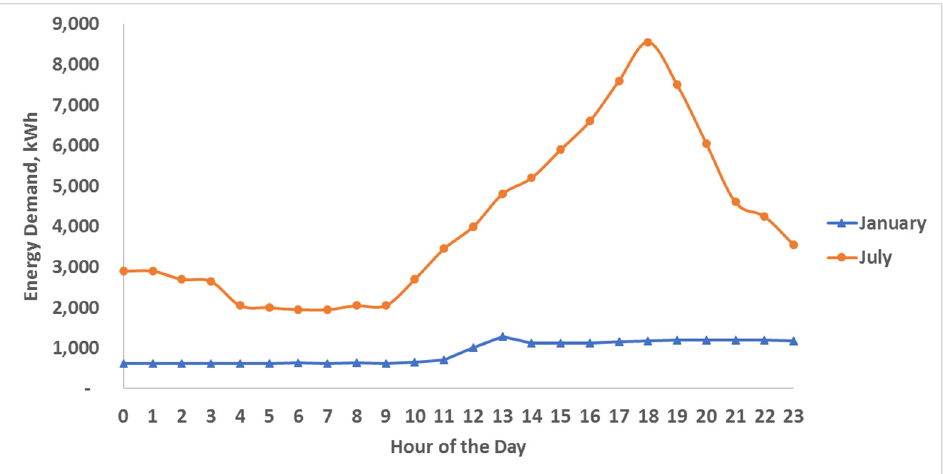
Figure 1. Hourly electric energy demand in the microgrid on two typical days in the summer and winter.